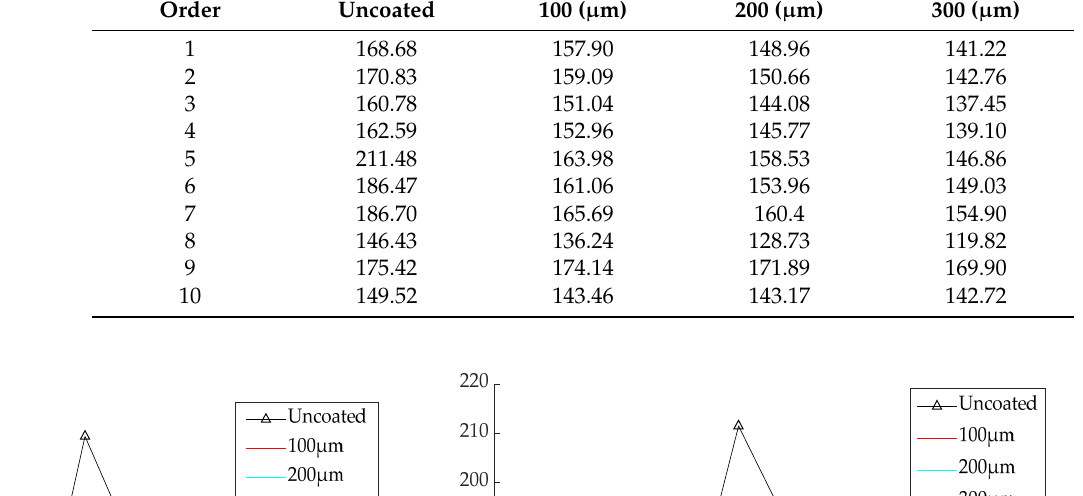
Figure 5. Aviation hydraulic pipeline mode shapes.